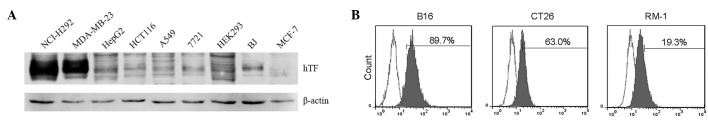
Expression of tissue factor (TF) in human and mouse cell lines. (A) Expression of TF in human cell lines analyzed by western blotting. (B) Expression of TF in mouse cancer cell lines analyzed by fluorescence-activated cell sorting (FACS).